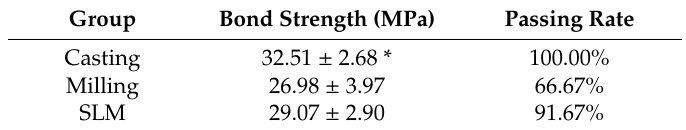
Table 5. Metal-Ceramic bond strength and passing rate ( ≥ 25 MPa) of the specimens.